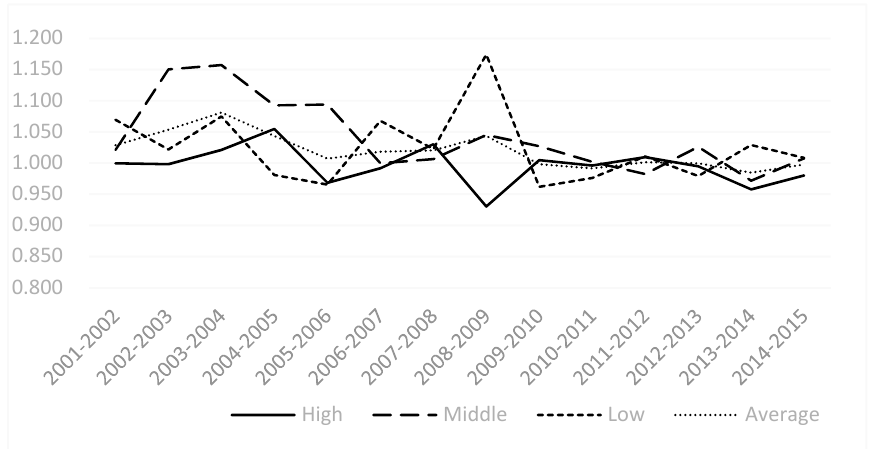
Figure 4. The catch-up effect of China’s heavy pollution industry from 2001 to 2015.